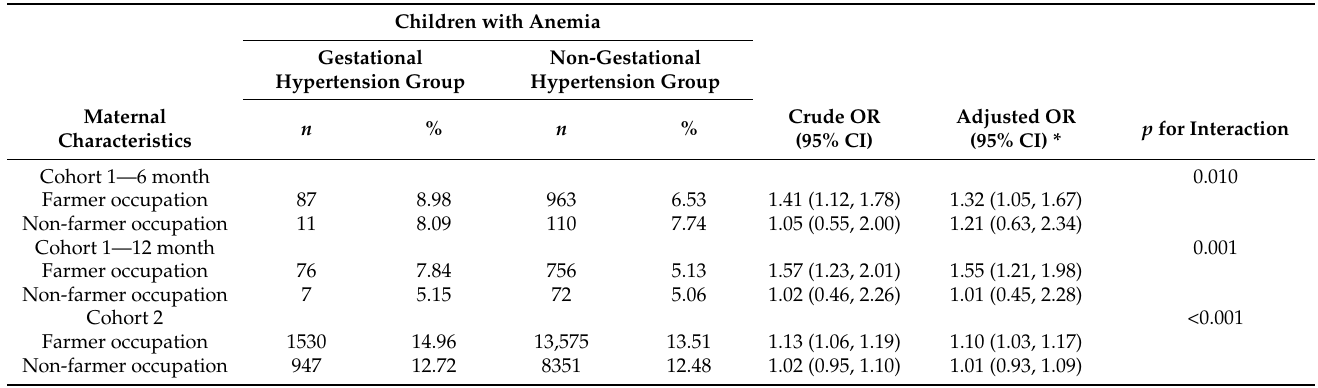
Table 4. Stratified analysis of the effects of gestational hypertension on children with anemia by